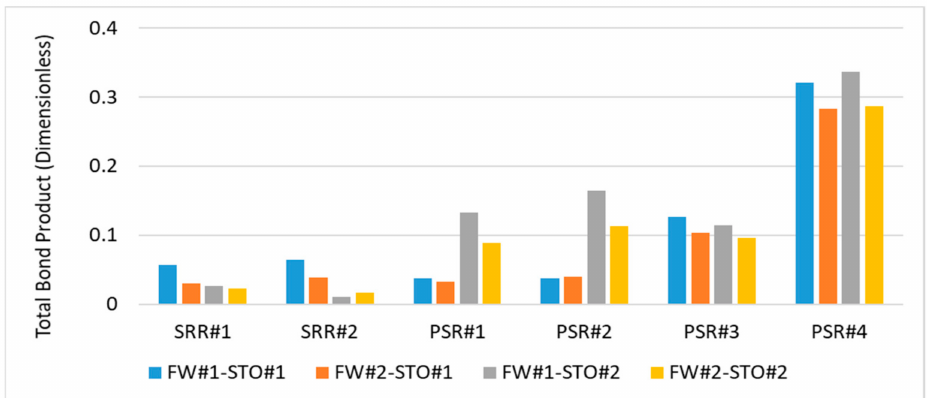
Figure 6. Total bond product (oil adhesion tendency) of reservoir rocks and mineral mixtures during FWI.